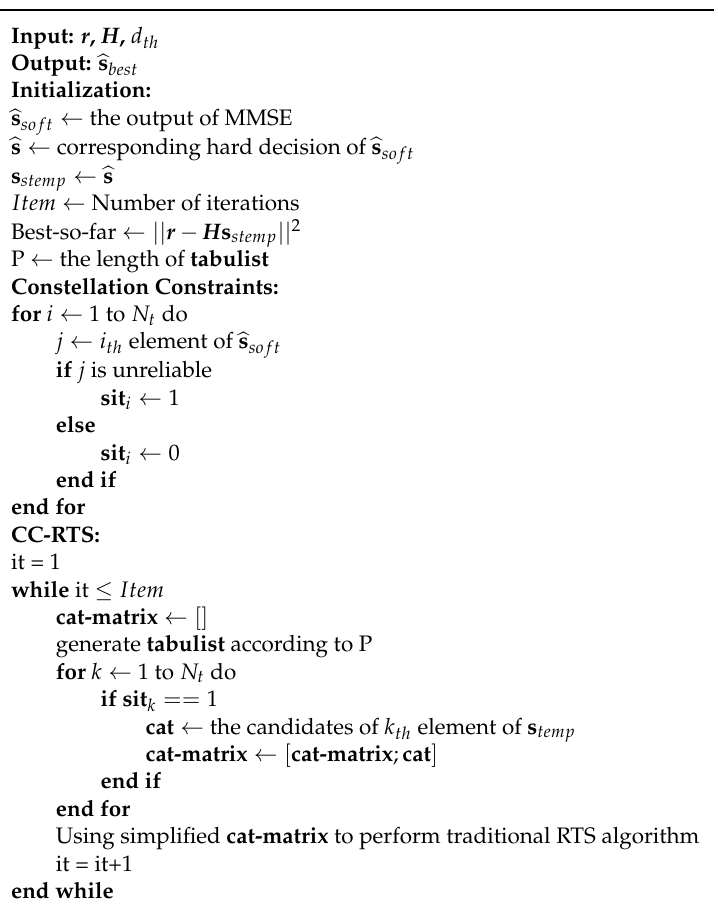
Table 2. The proposed CC-RTS algorithm.